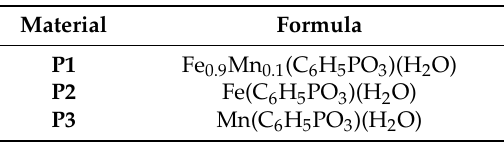
Table 1. Molecular formulas of